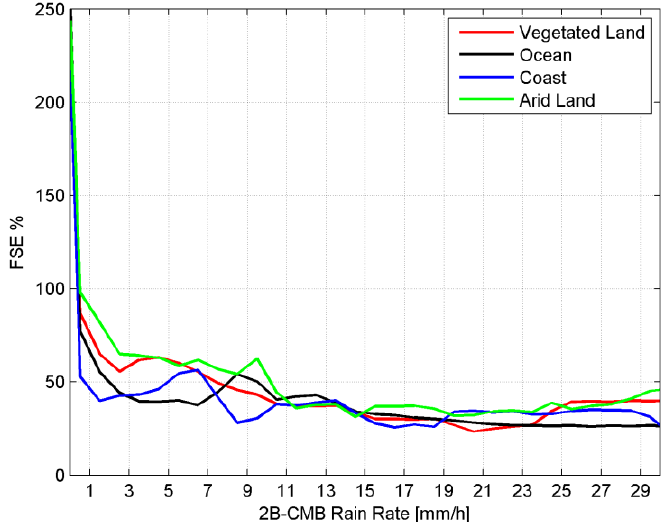
Figure 4. Standard error percentage (FSE%) of PNPR v3 retrieval with respect to the mean 2B-CMB rainfall rate value computed within 0.5 mm h −1 bins.